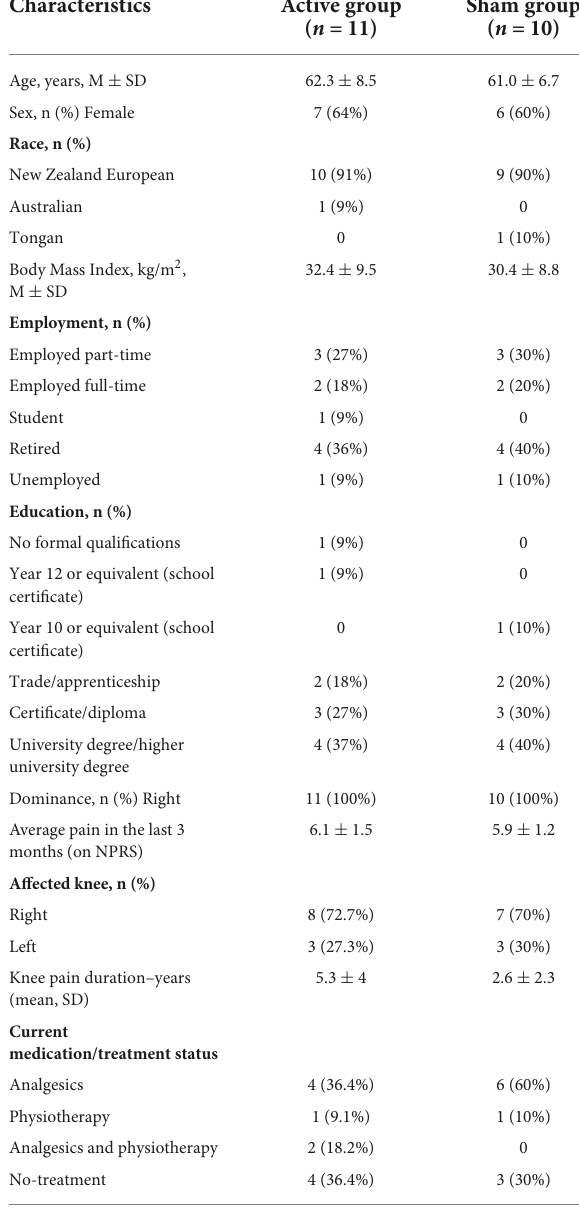
TABLE 1 Demographic and clinical characteristics of the